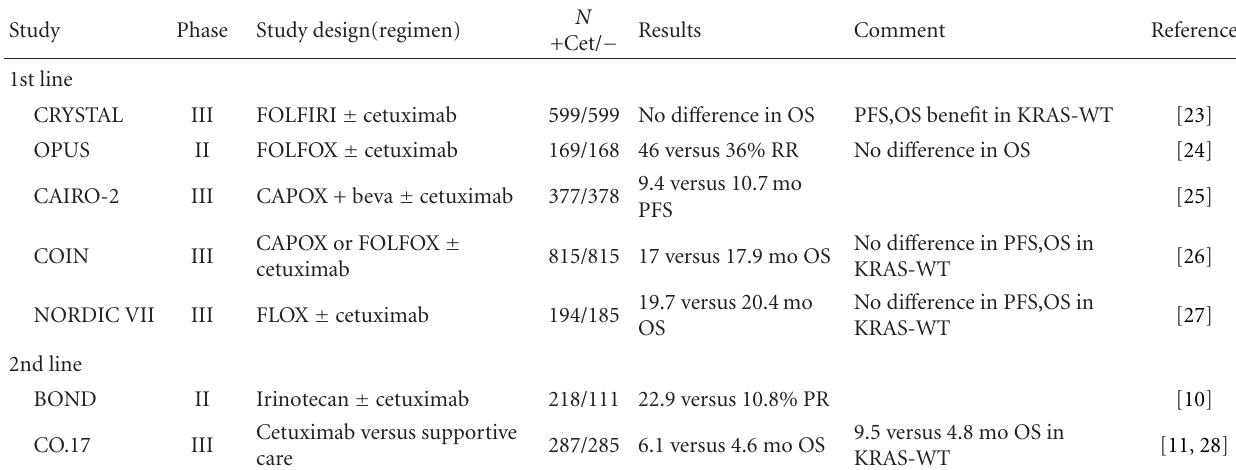
Table 2: Pivotal randomized clinical trials of cetuximab in